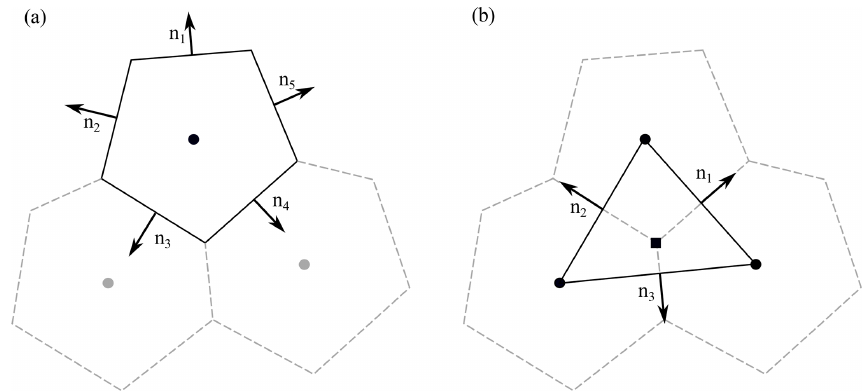
Figure 3. Contour integration lines used by the finite-volume stress divergence operator scheme. (a) Strain rate at cell centers (circle) are calculated from line integrals around primary mesh cells (solid line). (b) Stress divergence at cell vertices (square) are calculated from line integrals around the dual mesh cells (solid line). Directions of normal vectors used in the integrals are shown for both